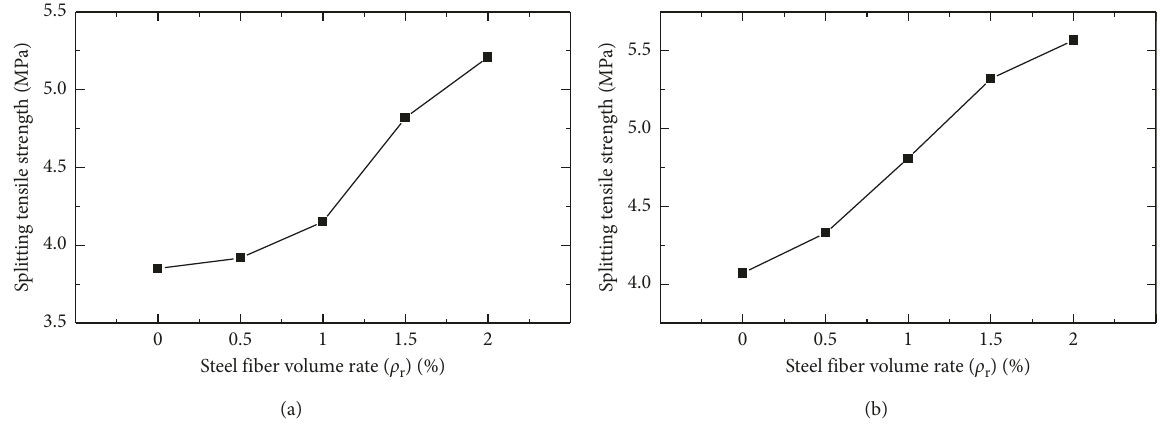
Figure 11: Relationship between splitting tensile strength and steel fiber content. (a) CF50; (b)